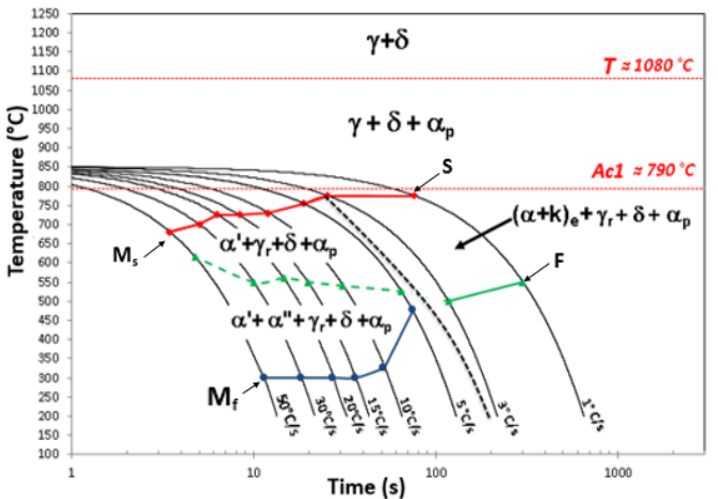
Figure 9. Continuous cooling transformation diagram (CCT) obtained for the Fe-Mn-Al-C alloy, highlighting the phases present in each region ( γ r = retained austenite; δ = δ -ferrite; α = α -ferrite; α p = proeutectoid α -ferrite; k = k-carbide; ( α + k) e = eutectoid microconstituent; α′ = BCC martensite; α″ = BCT martensite; S = eutectoid decomposition start temperature ( α + k) e ; F = eutectoid decomposi- tion finish temperature; M s = martensitic transformation start temperature; M f = martensitic trans- formation finish temperature).